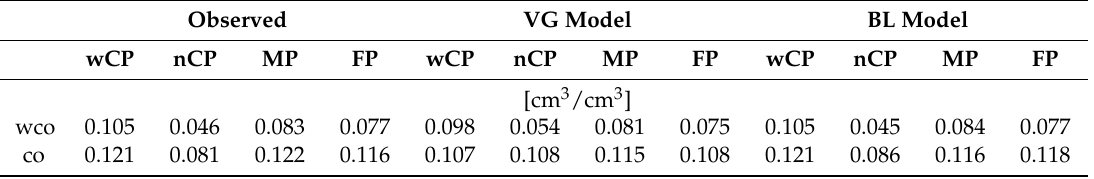
Figure 5. Fitted and observed pore size distribution as ratio of changing volumetric water content ( θ ) and pressure head (h) of the boulder marl without compost (wco) and with compost (co) considering the VG model [9] and BL model [22]. Table 14. Bimodal and observed pore size distribution of the boulder marl without compost (wco) and with compost (co) considering the unimodal VG model [9] and the bimodal BL model [22]. The pores sizes are classified as follows: wCP = wide coarse pores (>50 µ m; > − 60 hPa), nCP = narrow coarse pores (50–10 µ m; − 60 to − 300 hPa), MP = medium pores (<10–2 µ m; − 300 to − 15,000 hPa), FP = fine pores (<2 µ m; < − 15,000 hPa).